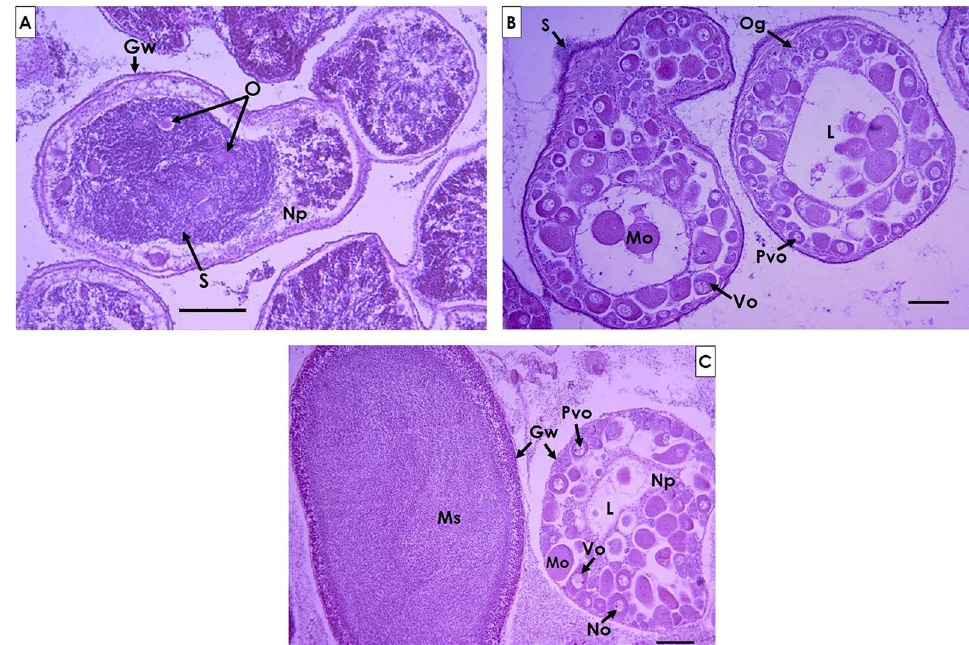
Figure 3. Gonad section of specimens with the presence of hermaphroditism, ( A ) gonad section with a larger presence of male gametes, ( B ) gonad section with a larger presence of oocytes, and ( C ) gonad with a similar proportion of both gametes. Gw gonad wall, L lumen, Mo mature oocytes, Ms mature spermatozoa, No nucleolus, Np nutritive phagocytes, O oocytes, Og oogonia, Pvo previtellogenic oocytes, S spermatids, Vo vitellogenic oocytes. Scale bars are 100